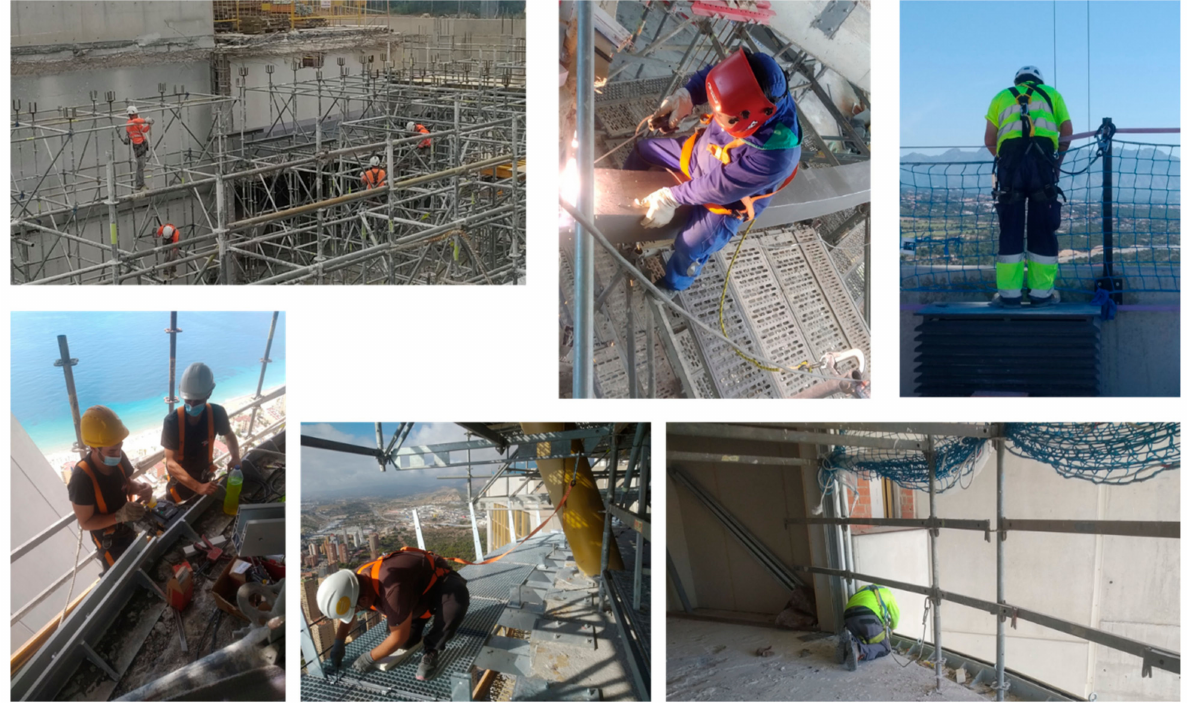
Figure 1. Temporary work at height with FAS with